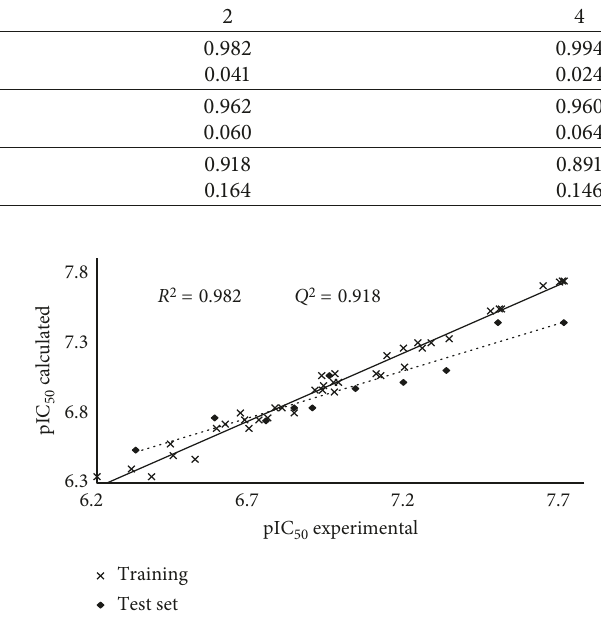
Table 5: The ensemble models with the corresponding regression coefficients and MAE values. Model IBK RF Num. var.